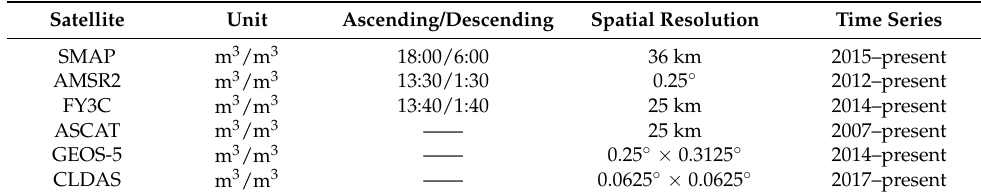
Table 1. Comparison of global soil-moisture products.